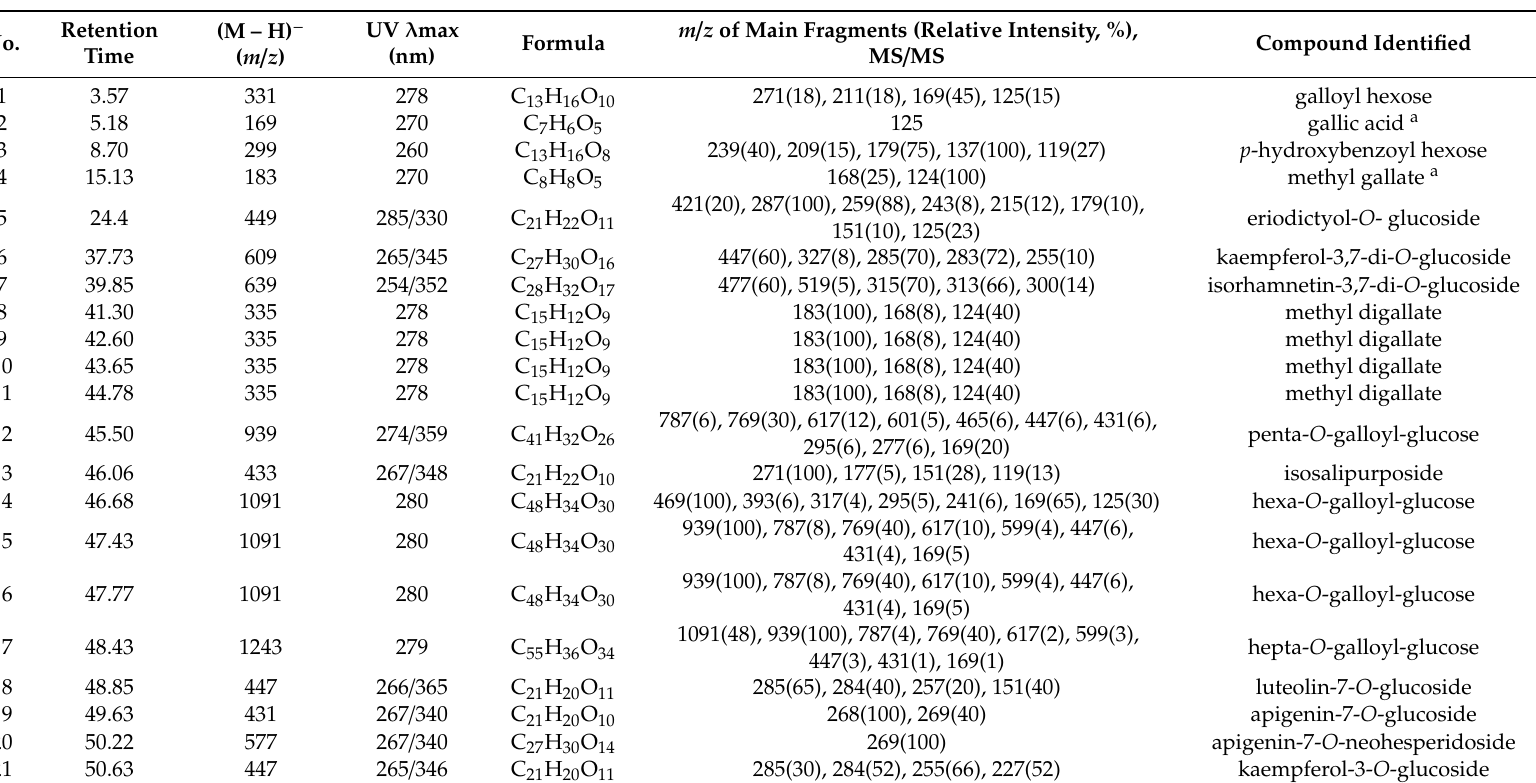
Table 1. Individual phenolic compounds identified in the methanol extracts of the edible tree peony flower by HPLC-quadrupole time-of-flight mass spectrometer (Q-TOF-MS) a